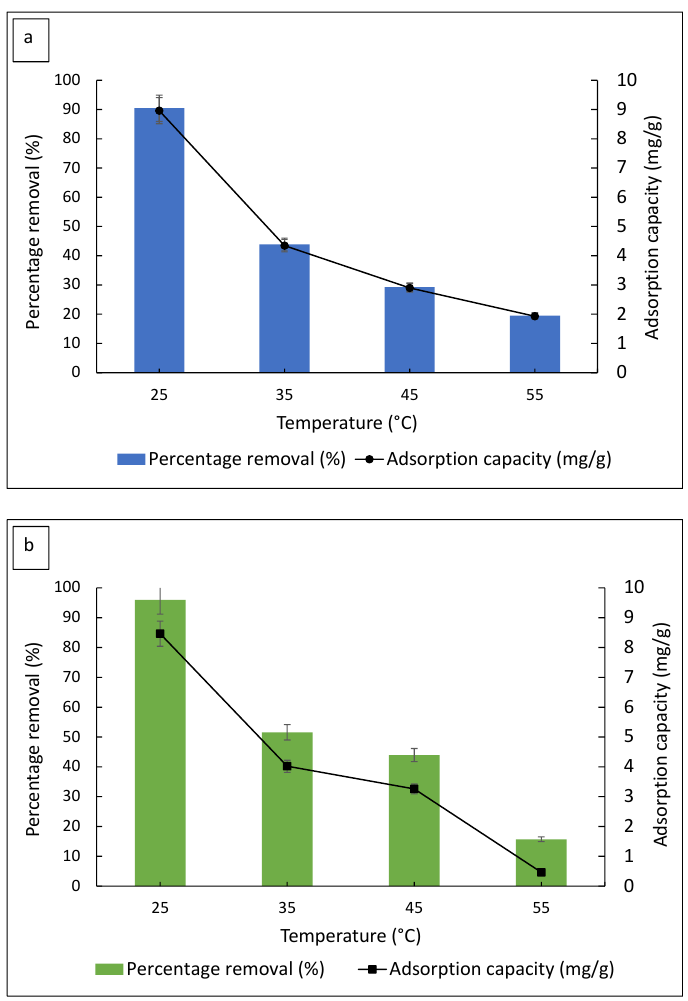
Figure 7. The effect of the solution temperature on the percentage removal of ( a ) MB and ( b ) MG.